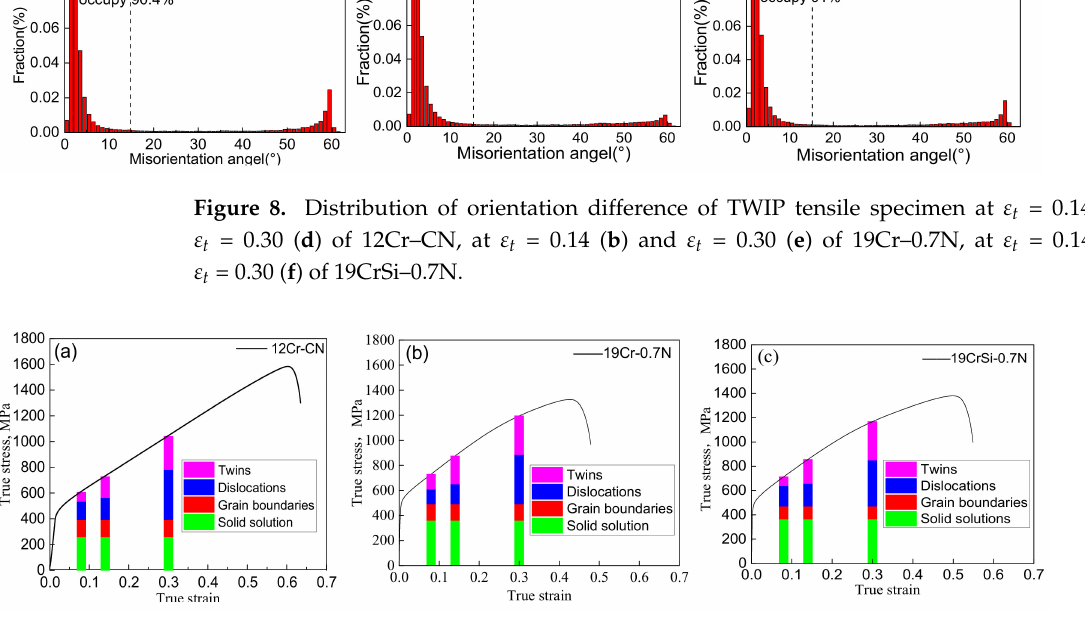
Figure 9. The respective contributions of twins, dislocations, grain boundaries, and solid solution to the flow stress during plastic deformation: ( a ) 12Cr–CN, ( b ) 19Cr–0.7N, ( c )